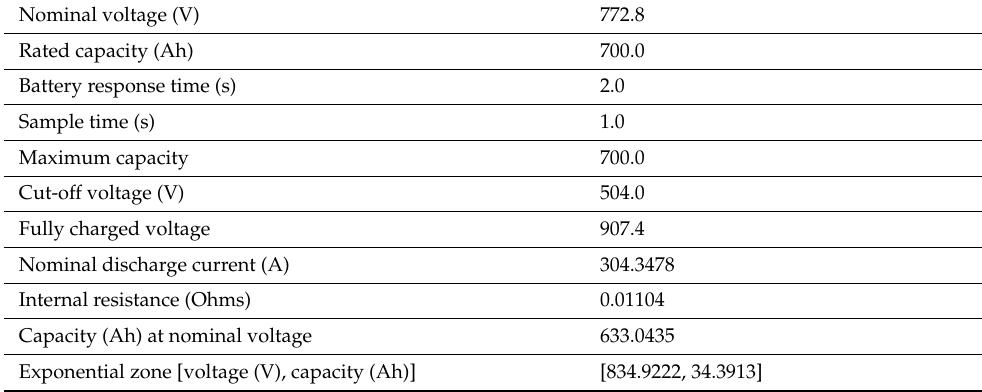
Table 4. Battery parameters.